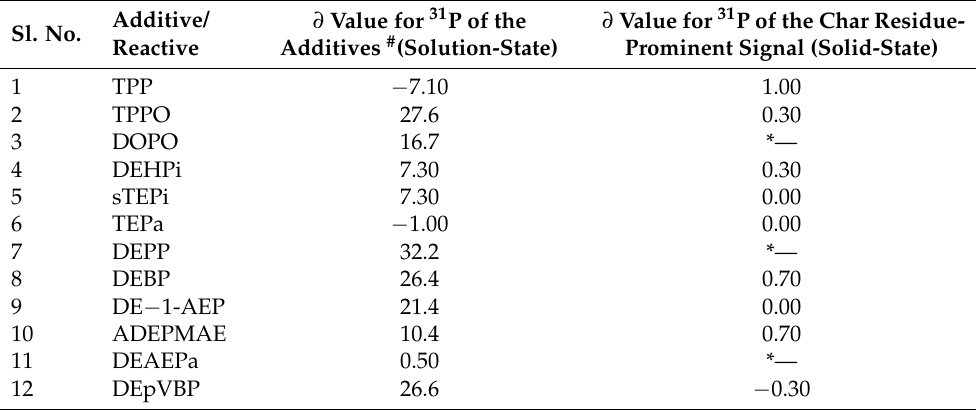
Table 5. Chemical shift values ( ∂ in ppm) of P nucleus in the additives/reactives and in the char residue obtained from PSt-based